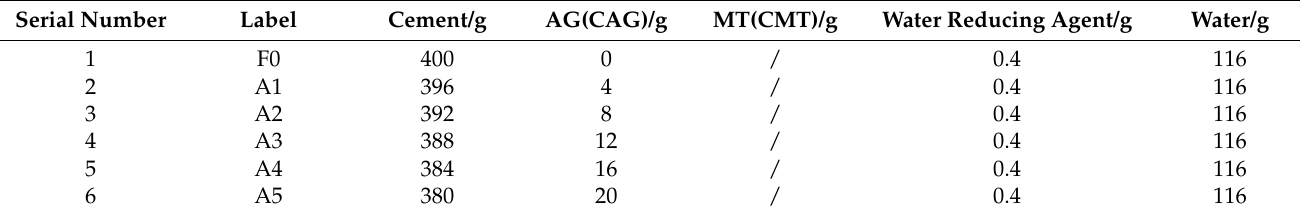
Table 3. Proportion of cement slurry sample